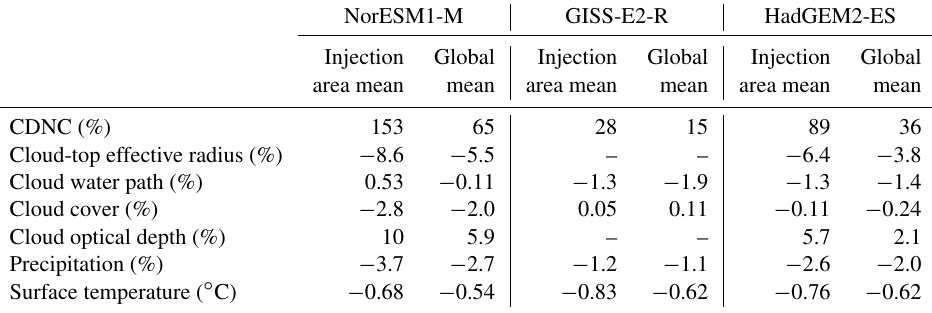
Table 1. Mean percentage changes in CDNC, cloud-top effective radius, cloud water path, cloud cover, cloud optical depth, precipitation, and surface air temperature ( ◦ C) due to sea spray climate engineering. The changes represent the percentage difference between G4sea-salt (with climate engineering) and RCP4.5 (without climate engineering) averaged over the period 2035–2065 for the injection area and globally. The change in CDNC represents the change in cloud droplet number concentration within the model layer below 700hPa with maximum concentration. Cloud-top effective radius and cloud optical depth could only be diagnosed for NorESM1-M and HadGEM2-ES. Cloud optical depth has been estimated using Eq. (1) (Stephens,